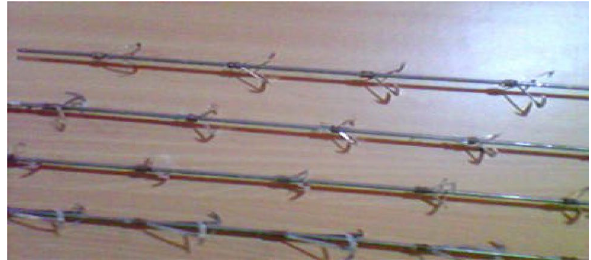
Fig. 4 Photograph of modified insert fitted on the central